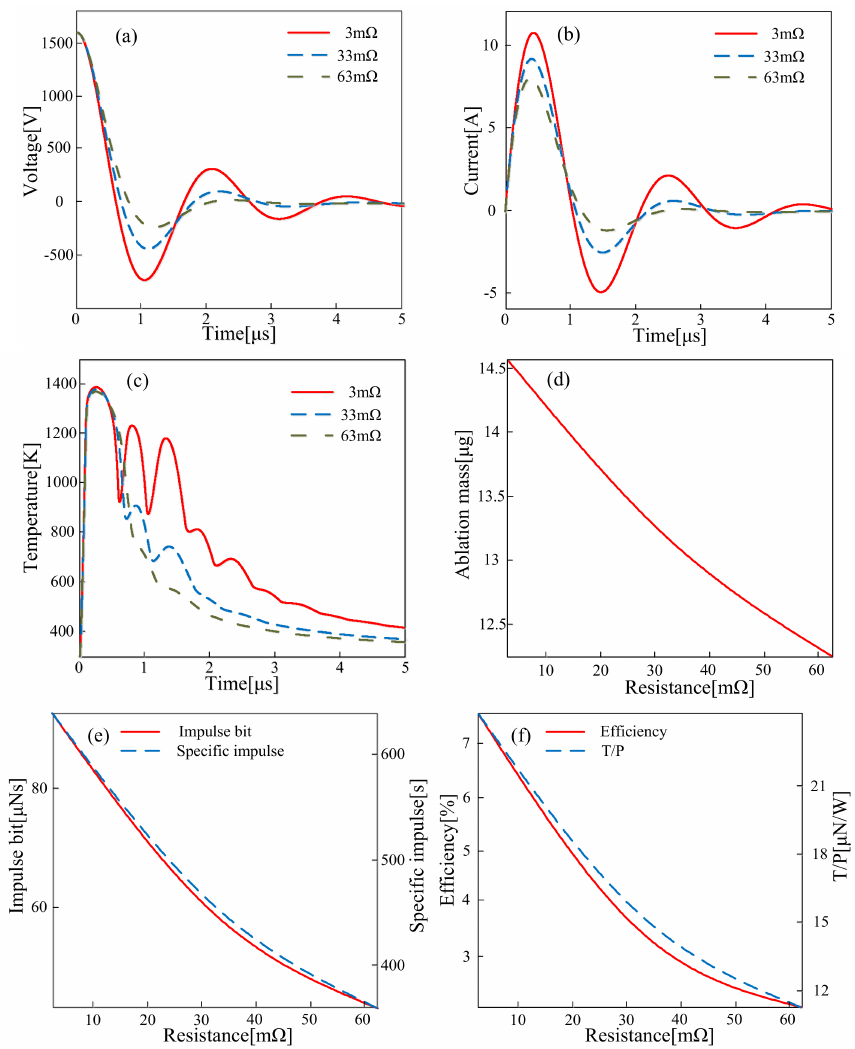
Figure 10. Simulation results at different external resistances: ( a ) Discharge voltage waveform; ( b ) discharge current waveform; ( c ) variation of ablation surface temperature with time; ( d ) variation of ablation mass with external resistance; ( e ) variation of impulse bit and specific impulse with external resistance; ( f ) variation of efficiency and ratio of thrust to power with external